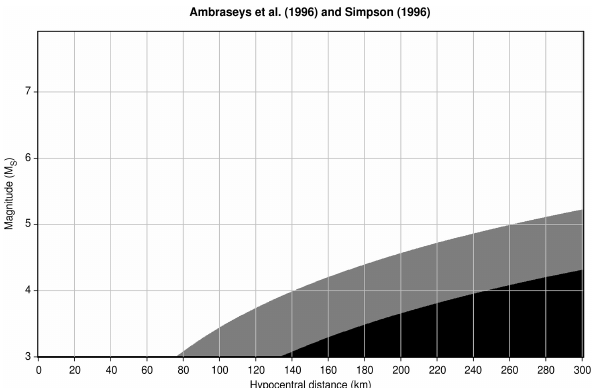
Figure 5. The graph shows, as a function of the magnitude ( M S ) and of the hypocentral distance, the detection performance of the accelerometer integrated into MEMS device model 1044_0. The chart was obtained comparing the values of standard deviation of the noise self-produced by the MEMS sensor with the PGA values, expected on the horizontal components, determined by the empiri- cal law of Ambraseys et al. (1996) and Simpson (1996). The white and gray areas are those where the expected PGA exceeds the stan- dard deviation of the MEMS accelerometer self-noise by a factor of 10, for sites with soft sediments and bedrock outcrops,